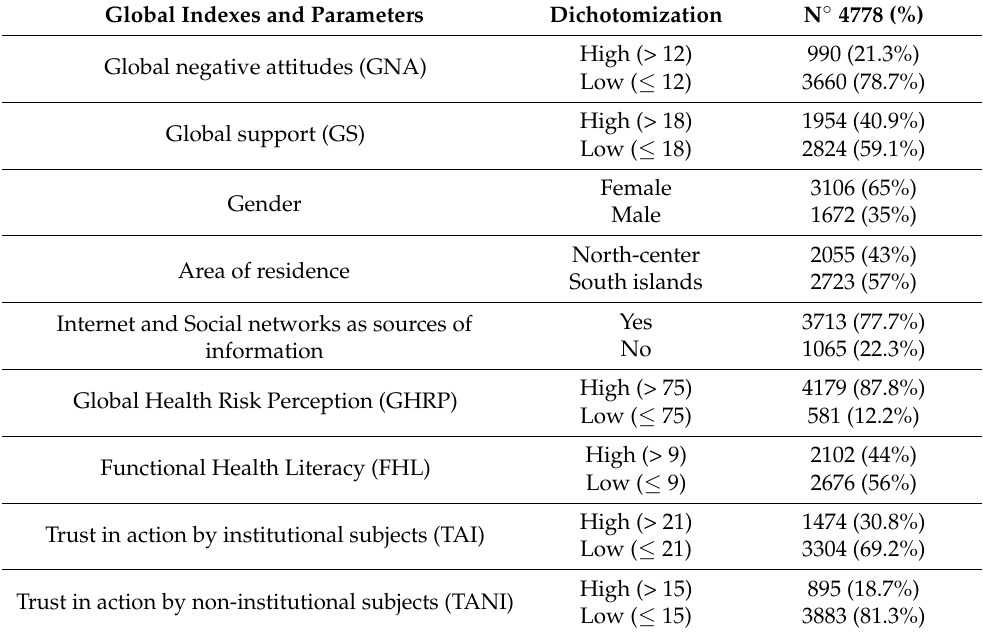
Table 2. Global indexes and parameters used as independent variables in the multivariable logistic regression models of pro-environmental attitudes (PAPEB) and behaviors (APEB). The percentage values refer to the total study population (4778